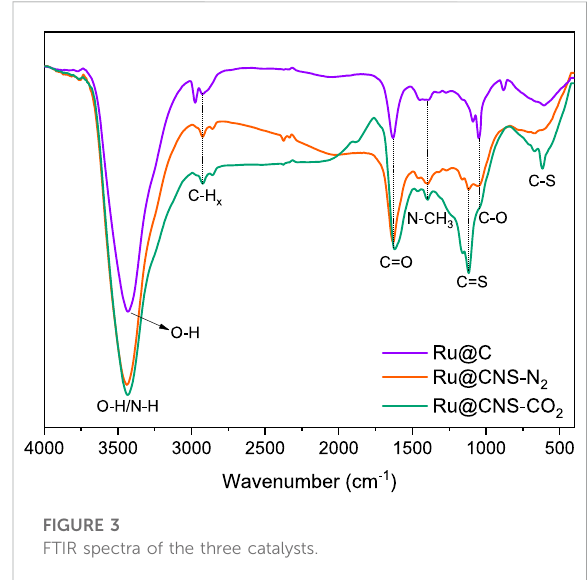
FIGURE 3 FTIR spectra of the three